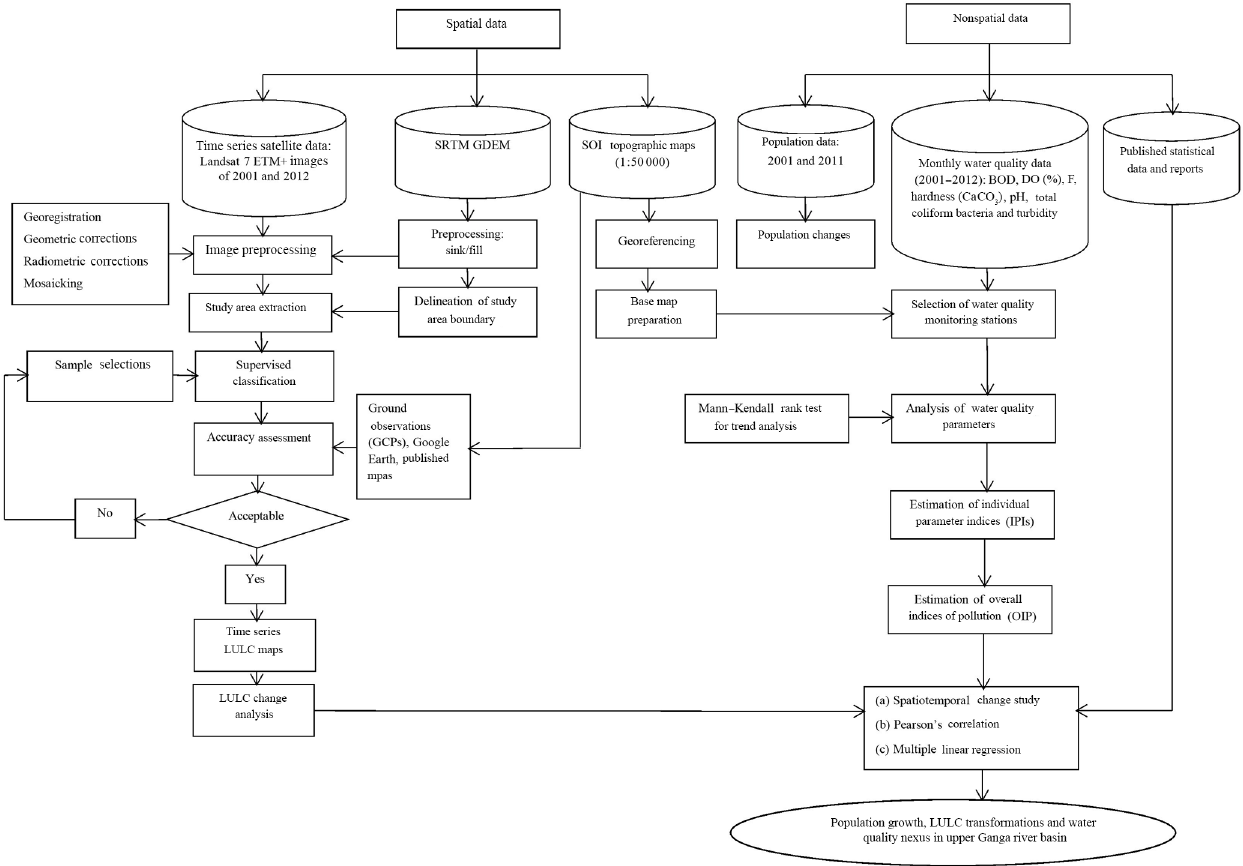
Figure 2. Flowchart illustrating methodology and steps followed in the